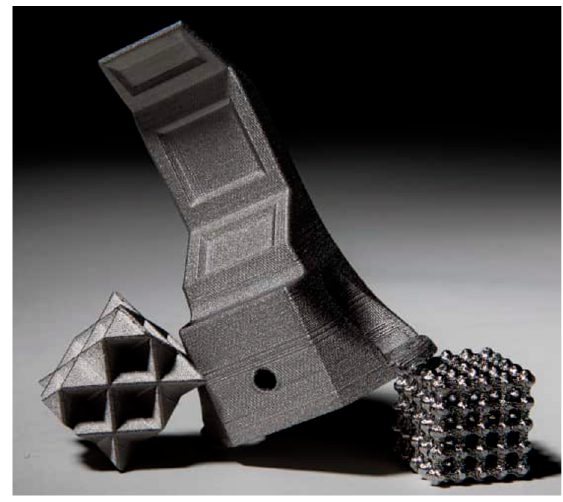
Figure 5. Elements printed from Ultrafuse 316 [25].